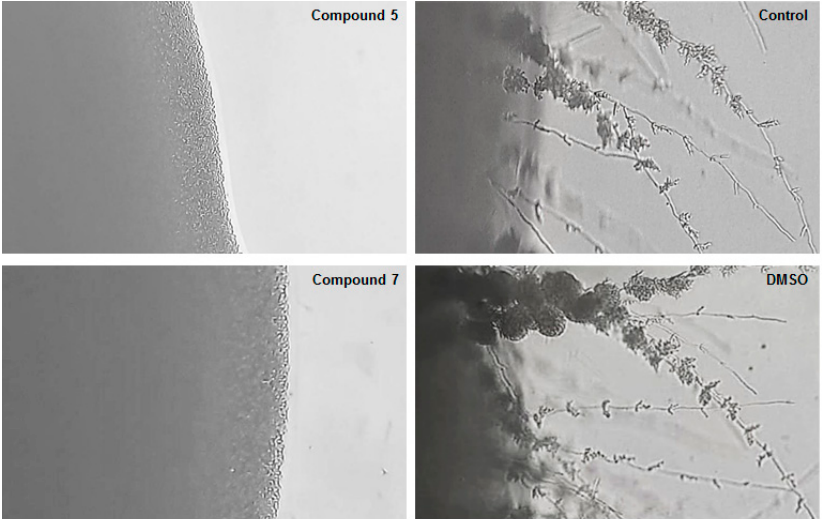
Figure 4. Impact of chalcones 5 and 7 at IC 50 values on C. albicans ATCC 10231 invasion potential determined in the Spider agar assay. The colony edges were imaged using a light microscope at the different experimental conditions. DMSO, used as control, did not interfere with C. albicans filamentation. The presence of pseudohyphal growth area at the colony edges was determined using a light microscope.